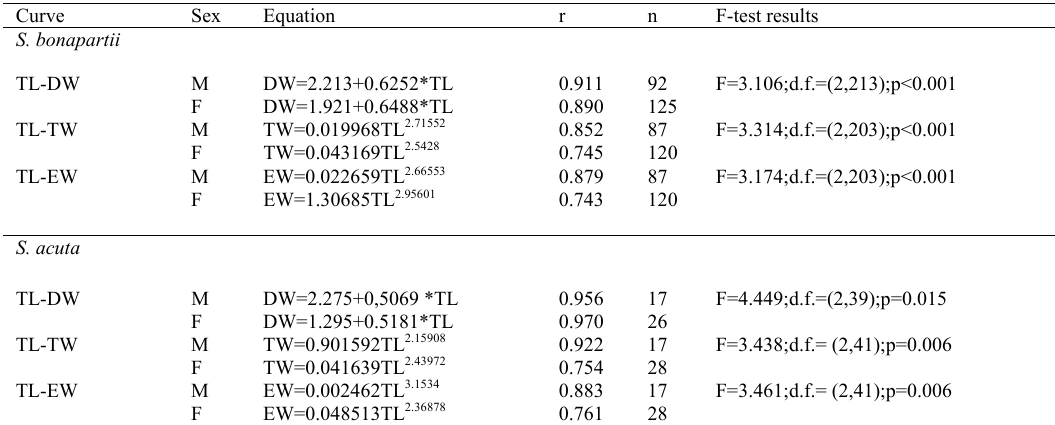
Table 1. Relationships analyzed for S. bonapartii and S. acuta . TL=total length (cm), DW=disc width (cm), TW=total weight (g), EW=eviscerated weight (g) for males (M) and females (F) with the respective potential regression equation; correlation coefficient (r) and sample number